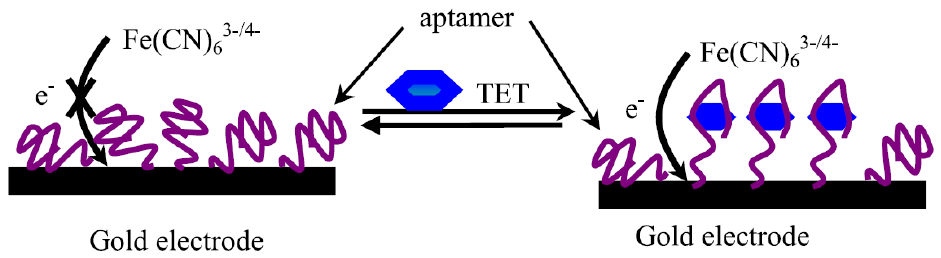
Figure 9. Binding of Tetracycline with Tet-binding Aptamers